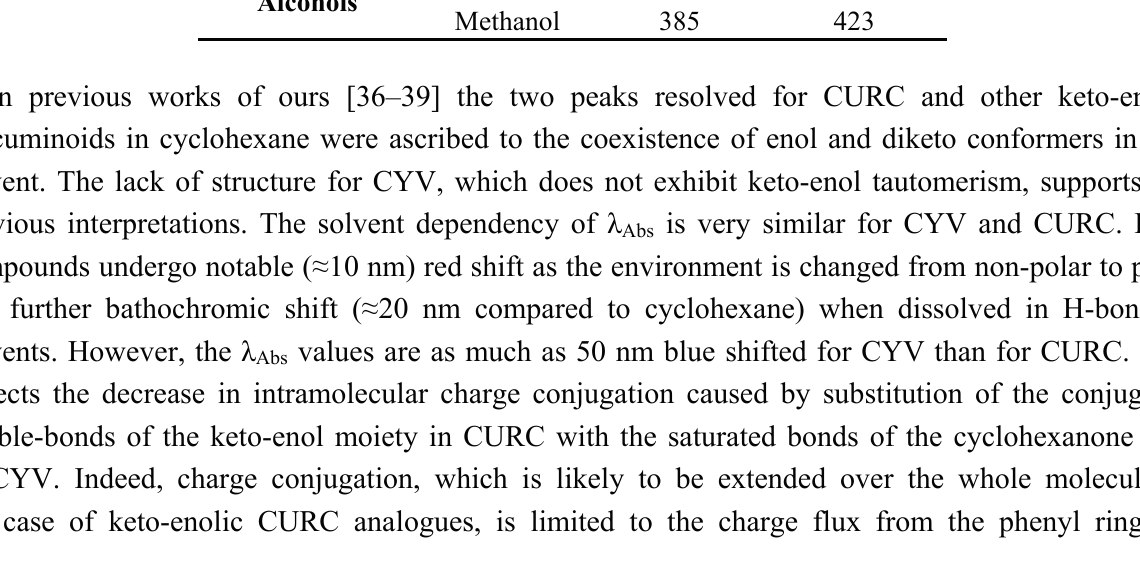
) and main absorption Abs